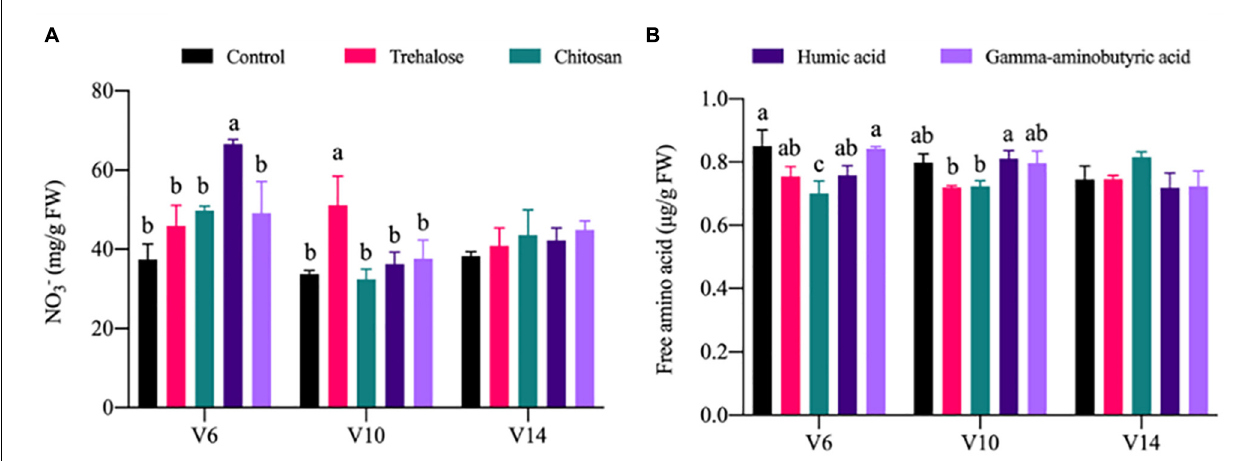
FIGURE 3 | Effects of PGRs on nitrogen metabolite accumulation in maize at different growth stages. Statistical analysis was used to compare means of PGR treatments shown in different colors; significantly different treatments within each stage are labeled with different lowercase letters ( P < 0.05; n = 3), and the lack of such letters indicates there was no significant difference. V6, V10, and V14 represent the 6-, 10-, and 14-leaf stages of vegetative growth, respectively. FW, fresh weight. (A) NO −